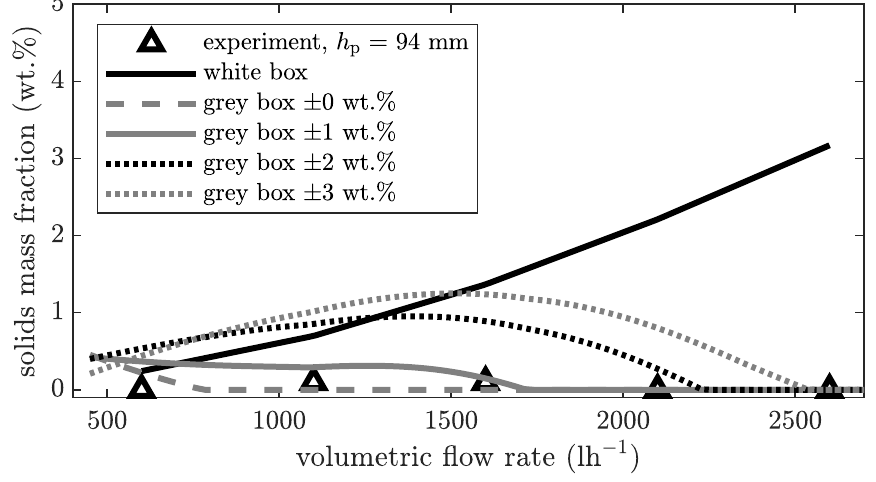
Figure 5. Solids mass fraction of the centrate for different volumetric flow rates and variation of the centrate trust interval at a constant rotational speed of n rot = 2950rpm for